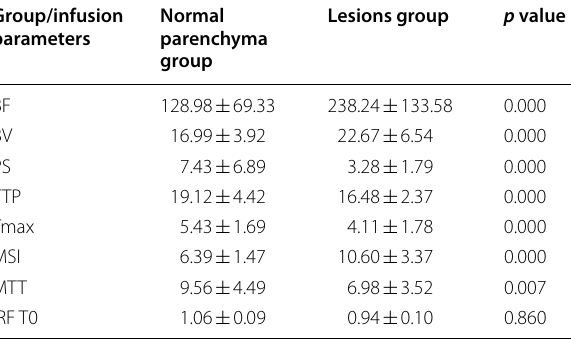
Table 3 Comparison of perfusion parameters between lesions group and normal parenchyma